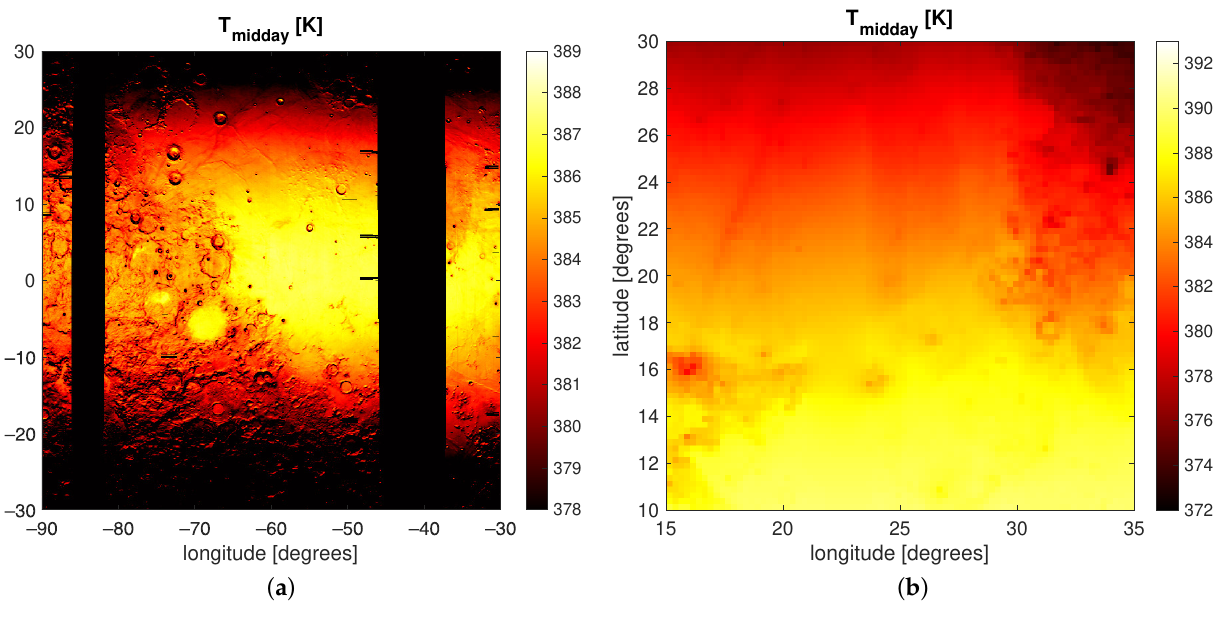
Figure 5. Temperature maps of the borders between mare and highland, and between high-Ti and low-Ti maria at midday. The edge of Oceanus Procellarum is visible, but there is no visible difference between high-Ti basalt in the western part and low-Ti basalts in the eastern part of Oceanus Procellarum (see also Figure A1). At the border between the low-Ti Mare Serenitatis (north) and the high-Ti Mare Tranquillitatis (south), the major factor driving temperatures is the latitude. For the high- Ti mare basalt in the very east of Mare Serenitatis and the low-Ti western part of Mare Serenitatis, the temperature differences are around 1K. ( a ) Western part of Oceanus Procellarum. ( b ) Mare Tranquillitatis and Mare